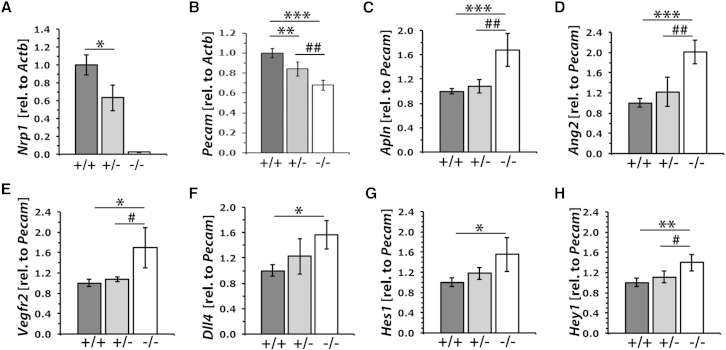
The Expression of Markers for Tip Cell Specification Is Not Impaired in Nrp1 Mutants(A and B) qPCR expression analysis of Nrp1 (A) and Pecam (B), normalized to Actb in E11.5 hindbrains of the indicated genotypes (n = 4 each); expression levels are shown as mean ± SD in mutants relative to wild-type.(C–H) qPCR expression analysis of the indicated tip cell markers and notch target genes in E11.5 hindbrains of the indicated genotypes (n = 4 each), normalized to Pecam to obtain an objective measure of tip cell marker expression relative to the amount of endothelium; expression levels are shown as mean ± SD in mutants relative to wild-type.Asterisks indicate p values for homozygous or heterozygous mutants relative to wild-type (∗p < 0.05, ∗∗p < 0.01,∗∗∗p < 0.001), hash tags p values for homozygous relative to heterozygous mutants (#p < 0.05, ##p < 0.01).